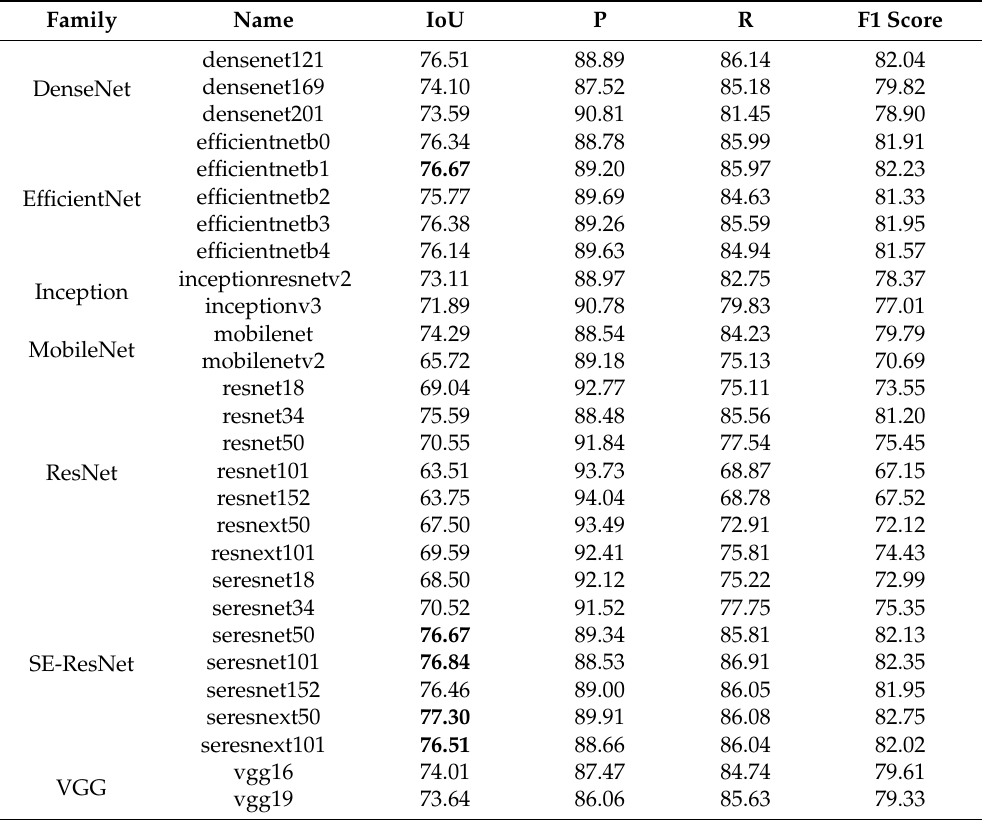
Table 8. Performance (mean values—%) classification based on the used backbone. Five best mIoU values are marked in bold